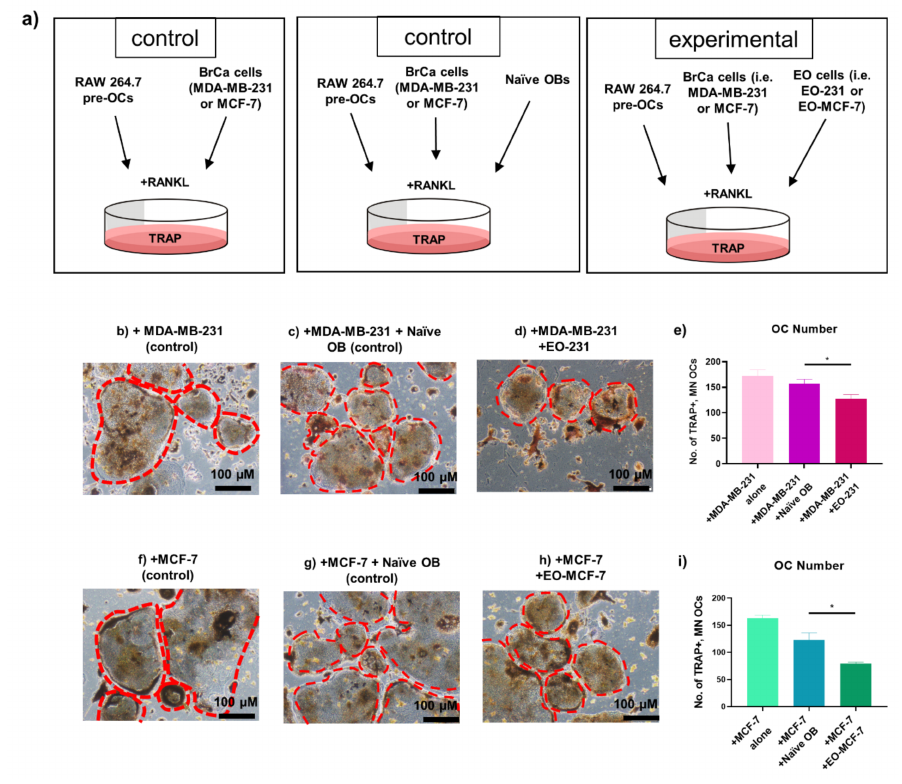
Figure 4. EOs Decrease the Number of TRAP+, Multinucleated Osteoclasts in the Presence of Breast Cancer Cells. ( a ) Cartoon of experimental design. As controls, RAW 264.7 pre-osteoclasts were co-cultured with either MDA-MB-231 human breast cancer cells in the presence of 50 ng/mL exogenous RANKL alone for six days or MCF-7 human breast cancer cells in the presence of 50 ng/mL exogenous RANKL alone for six days (first panel). As additional controls, RAW 264.7 pre-osteoclasts were co-cultured in the presence of 50 ng/mL RANKL for six days with either MDA-MB-231 or MCF-7 human breast cancer cells plus naïve osteoblasts (second panel). The experimental condition included RAW 264.7 pre-osteoclasts co-cultured with MDA-MB-231 human breast cancer cells plus EO-231 cells in the presence of 50 ng/mL exogenous RANKL for six days or MCF-7 human breast cancer cells plus EO-MCF-7 cells in the presence of 50 ng/mL exogenous RANKL for six days (third panel). After six days, the following conditions containing MDA-MB-231 human breast cancer cells were TRAP stained and imaged to identify mature osteoclast formation: ( b ) RAW 264.7 pre- osteoclasts co-cultured with MDA-MB-231 human breast cancer cells in the presence of 50 ng/mL exogenous RANKL alone; ( c ) RAW 264.7 pre-osteoclasts co-cultured with MDA-MB-231 cells plus naïve osteoblasts in the presence of 50 ng/mL exogenous RANKL or ( d ) RAW 264.7 pre-osteoclasts co-cultured with MDA-MB-231 cells plus EO-231 cells in the presence of 50 ng/mL exogenous RANKL. ( e ) The number (No.) of TRAP-positive, multinucleated ( ≥ 3 nuclei) mature osteoclasts were quantified for conditions containing MDA-MB-231 breast cancer cells. After six days, the following conditions containing MCF-7 human breast cancer cells were TRAP stained and imaged: ( f ) RAW 264.7 pre-osteoclasts co-cultured with MCF-7 human breast cancer cells in the presence of 50 ng/mL exogenous RANKL alone; ( g ) RAW 264.7 pre-osteoclasts co-cultured with MCF-7 cells plus naïve osteoblasts in the presence of 50 ng/mL RANKL; or ( h ) RAW 264.7 pre-osteoclasts co-cultured with MCF-7 cells plus EO-MCF-7 cells in the presence of 50 ng/mL RANKL. The number (No.) of TRAP- positive, multinucleated ( ≥ 3 nuclei) mature osteoclasts were quantified for conditions containing MCF-7 breast cancer cells ( i ). Representative images are shown. Scale = 100 µ M. N = 3–5. * p < 0.05. We observed a 19% reduction in the number of TRAP-positive, multinucleated ( ≥ 3 nu- clei) osteoclasts produced in the presence of EO-231 cells plus MDA-MB-231 breast cancer cells when compared to the number of TRAP-positive, multinucleated ( ≥ 3 nuclei)